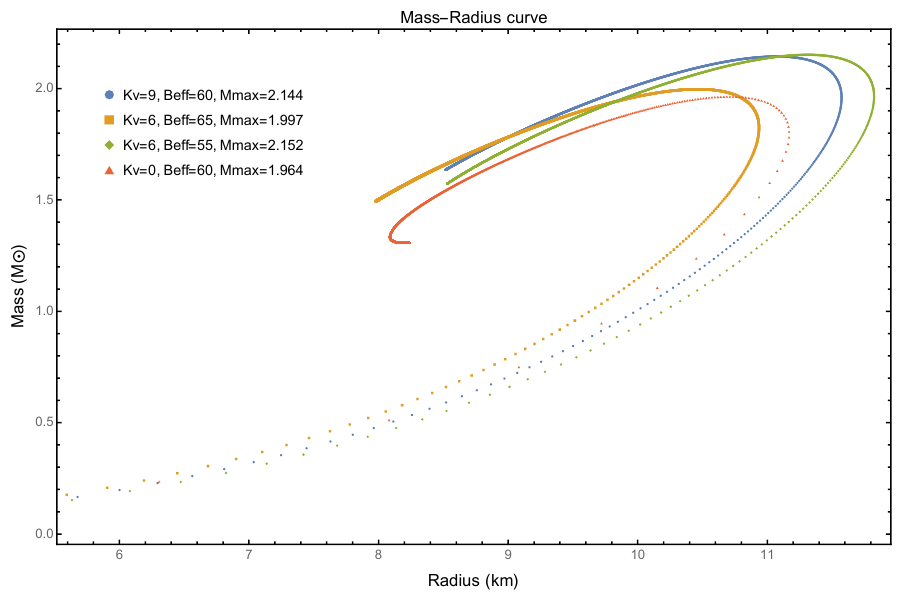
Figure 2. The mass–radius plot for strange stars in the vBag model ( K v (cid:54) = 0), compared to the tdBag model ( K v = 0). Parameters K v and B eff have been chosen to correspond to maximum mass values that can approach or exceed 2 M (cid:12)